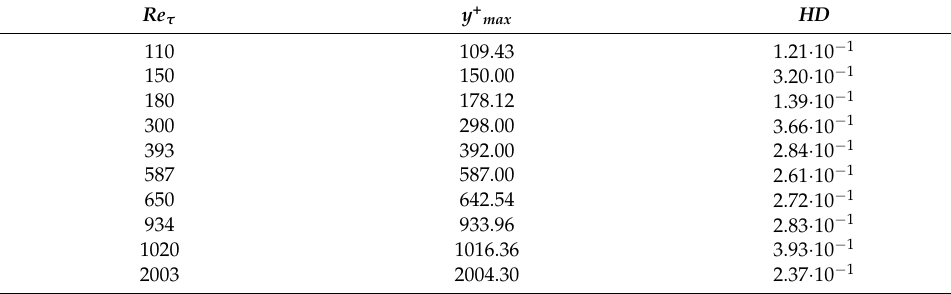
0 Figure 1. MVP; DNS data; and – ITM. The plots are shifted vertically by 10 units. Figure 1. MVP; ○ DNS data; and ─ ITM. The plots are shifted vertically by 10 units. (cid:35) Table 1. Re τ , y + max , and Hellinger distance He